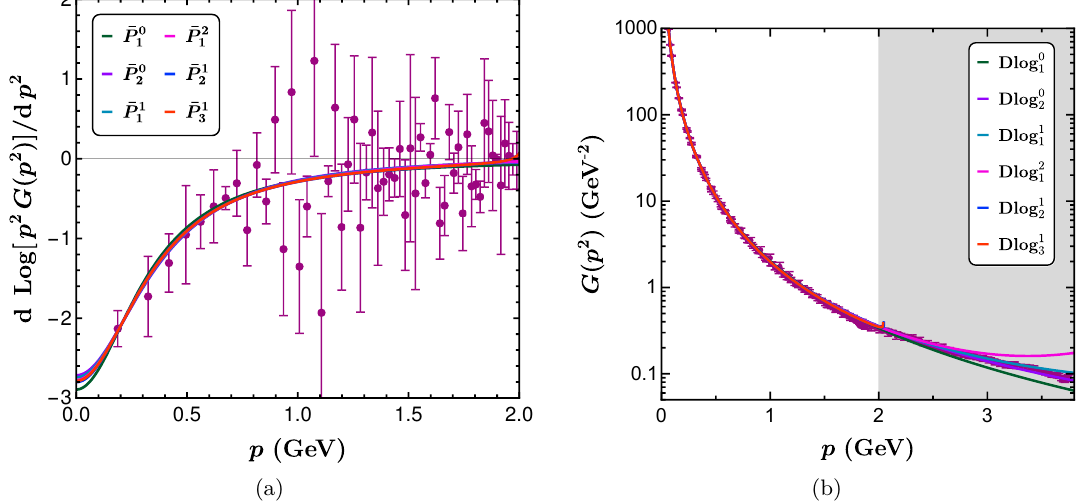
Figure 10 . (a) First-order numerical derivative of the logarithm of the ghost-propagator data together with the Padés ¯ P N ( p 2 ) used to build the D-Log PAs. (b) The lattice data for the ghost M propagator and the D-Log Padé approximants built from the first-order numerical derivative of the p logarithm of the data. The shaded region — corresponding to p = p 2 > 2 . 0 GeV — is excluded from the